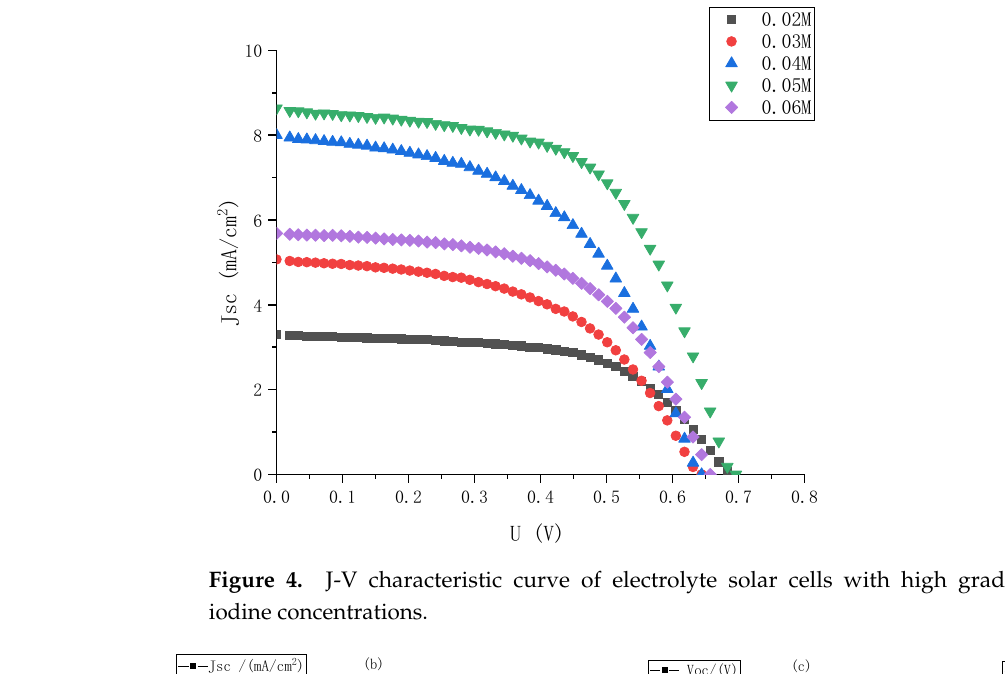
Figure 4. J-V characteristic curve of electrolyte solar cells with high gradient and different iodine concentrations.